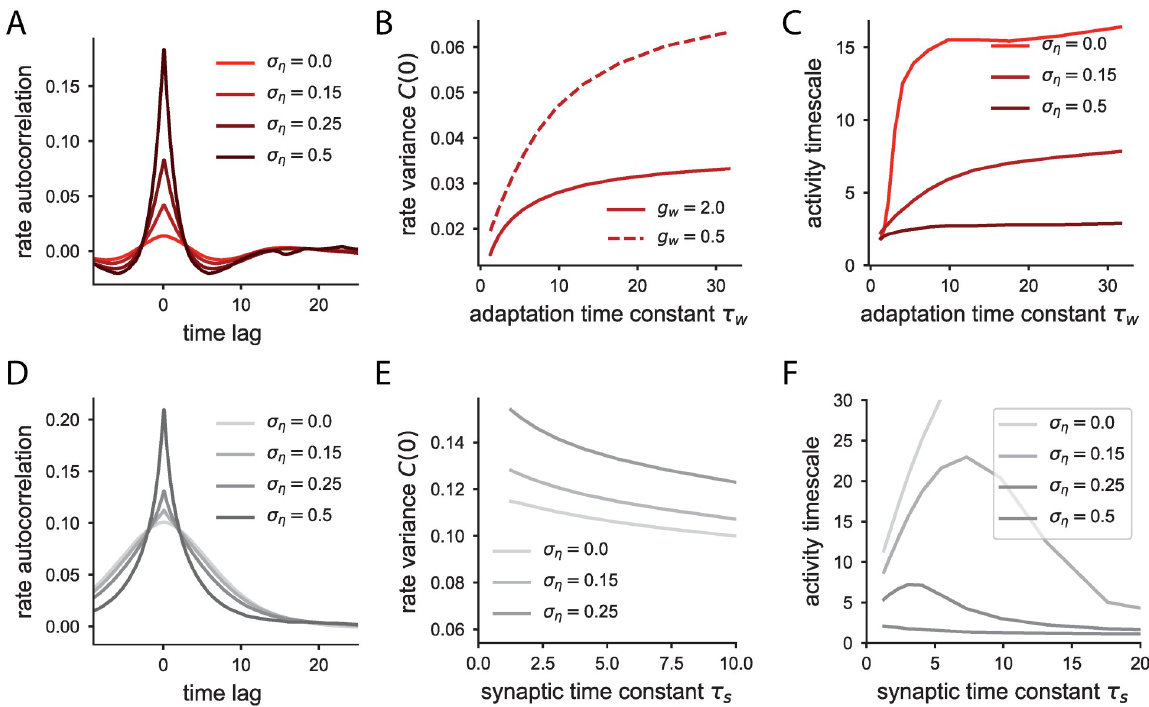
Fig 7. Autocorrelation function, variance of the firing rates and timescale of the network activity with external noise predicted by dynamical mean field theory. A: Autocorrelation function of the firing rates for the network with adaptive neurons for three different noise intensities. Adaptation time constant τ w = 1.25. B: Variance of the firing rate as a function of the adaptation time constant for two different adaption couplings g . Increasing the adaptation time constant or decreasing the adaptation coupling increases the variance. σ η = 0.15. C: w Timescale of the firing rate as a function of the adaptation time constant, and three different noise levels. Parameters: g w = 0.5, and ffiffiffiffiffiffiffiffiffiffiffiffiffiffiffiffiffiffiffiffi p þ g 2 C ¼ 1 : 2 . D: Autocorrelation function of the firing rate for the network with synaptic transmission for three different noise levels. J C E I Synaptic time constant τ = 1.25. E: Variance of the firing rate as a function of the synaptic time constant, for three different external noise levels. s Synaptic filtering reduces the variance. F: Timescale of the activity for the network with synaptic filtering and external noise.